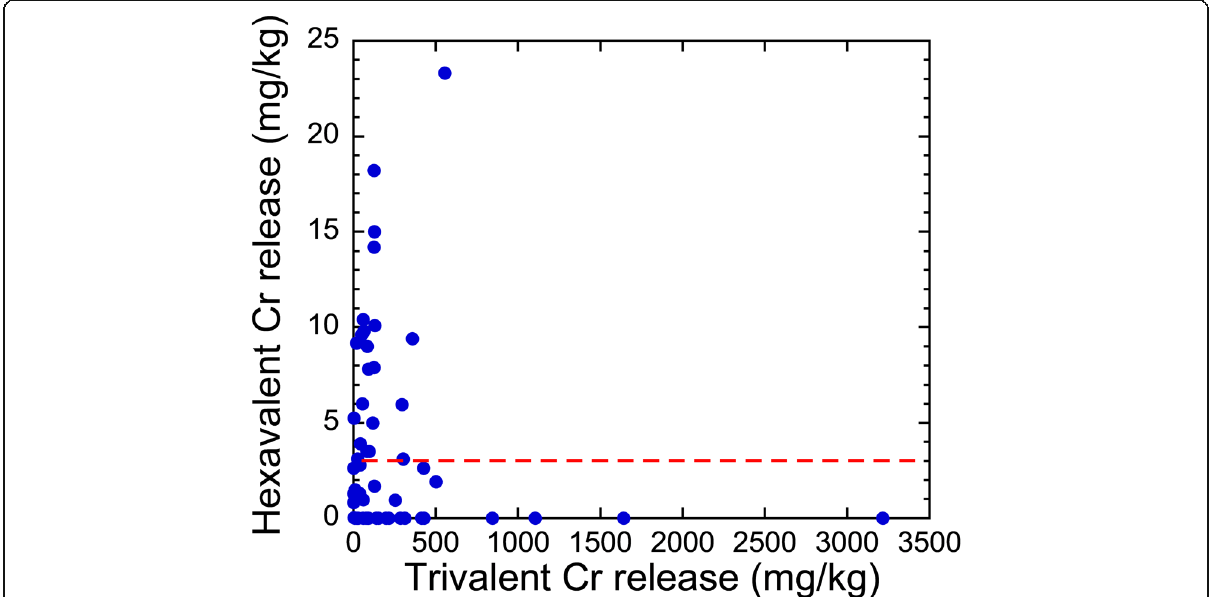
Fig. 5 Measured trivalent and hexavalent chromium release in mg/kg from different leathers and conditions of Fig. 1 (specified in Table S2), excluding non-measurable levels of hexavalent chromium due to color interferences. The red dotted line marks the restriction limit of 3 mg/kg for hexavalent chromium. Only leather items below that restriction limit are allowed to be placed on the market in the EU. Cr –